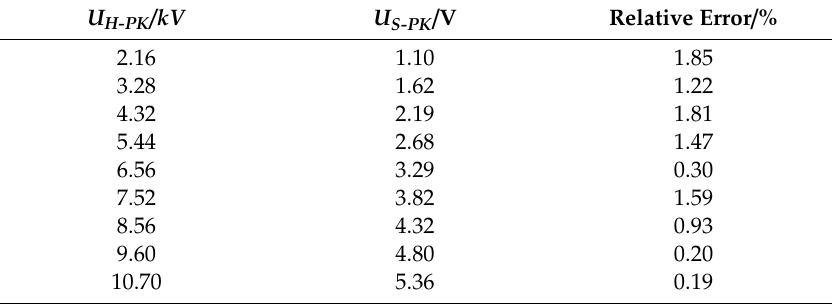
Table 4. Test results of transient response.